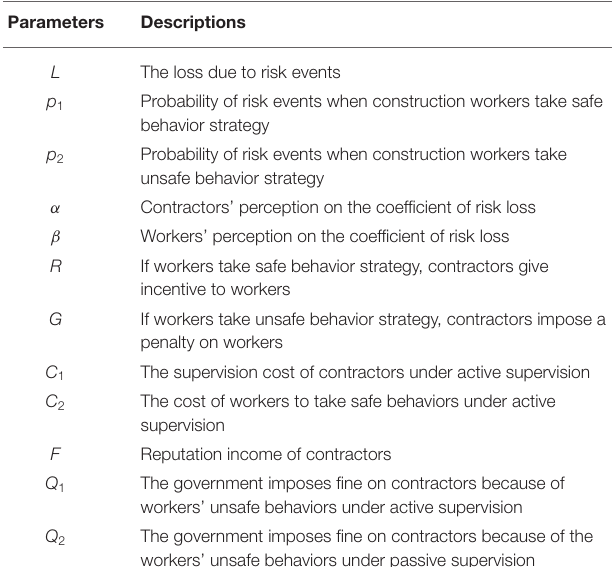
TABLE 1 | Main parameters and